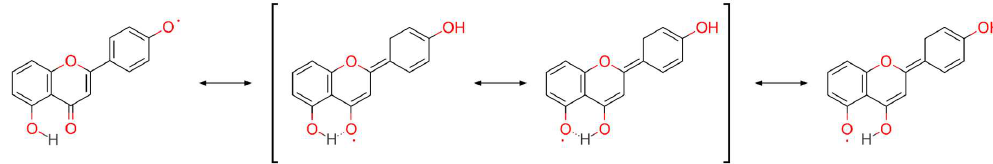
Figure A1. Electron density swap mechanism.